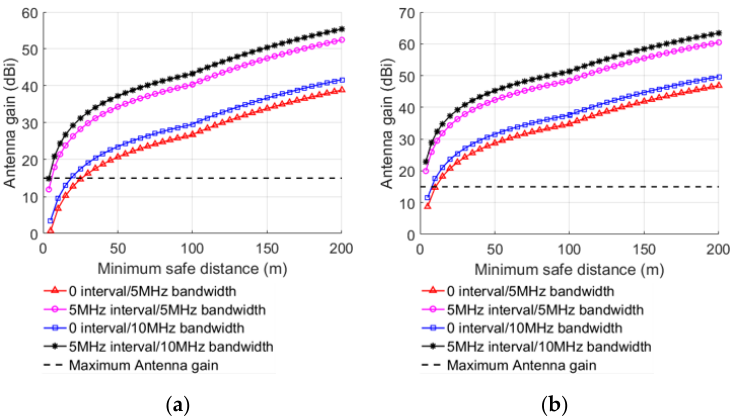
Figure 4. Minimum safe distance with the antenna gain at different UE positions when UE interfering with BS: ( a ) platform, ( b ) carriage. Table 4. LTE FDD UE interfering with LTE-M BS.